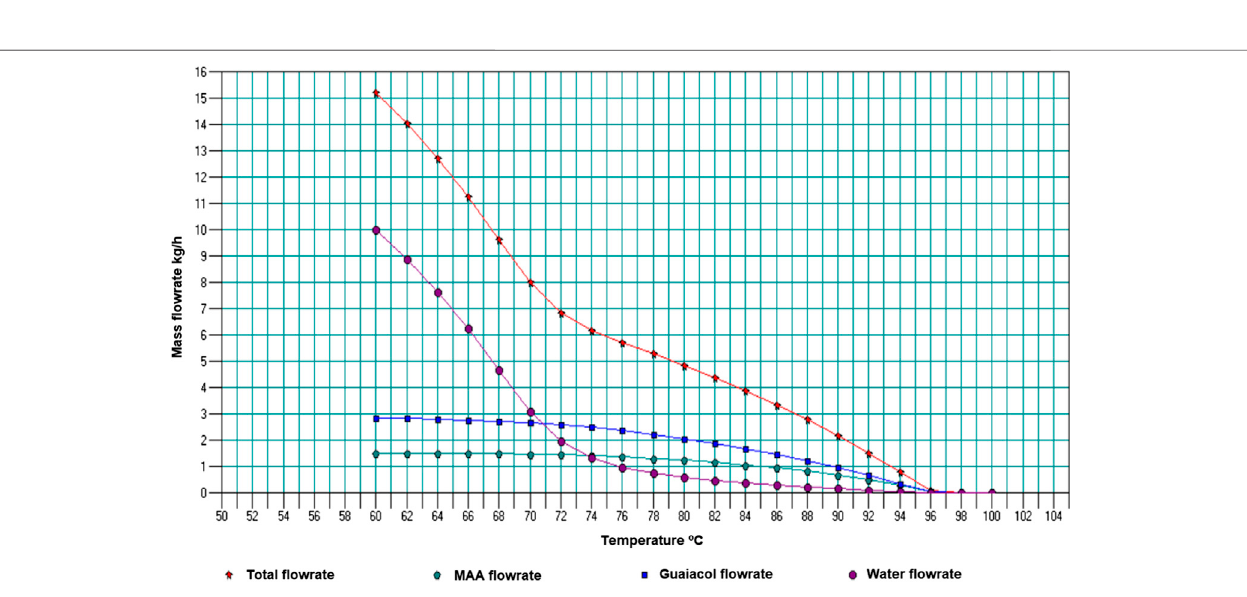
Frontiers in Energy Research |